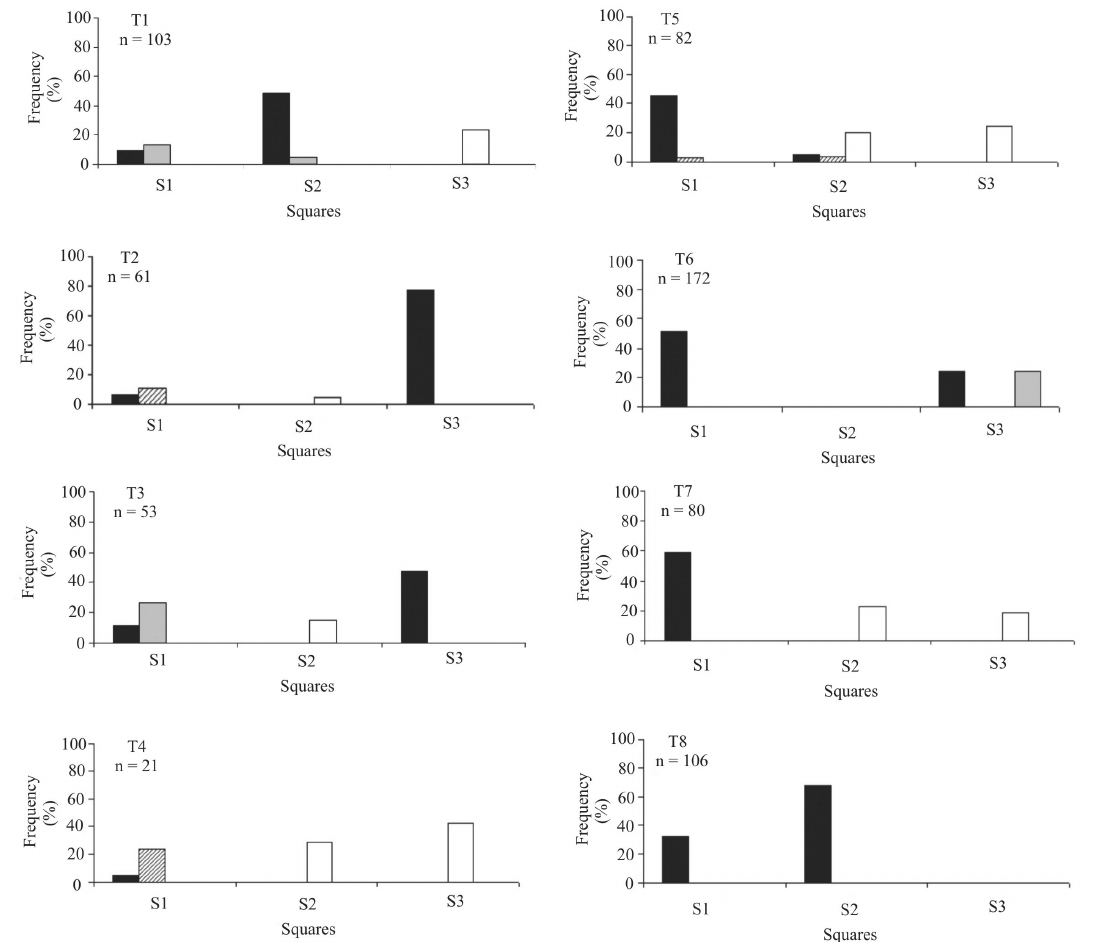
Fig. 3. – Overall frequency distribution of Uca species collected at Pacoti River mangrove, northeast Brazil, in the squares at each transect sam- pled. Black bars: U. leptodactyla , white bars: U. thayeri , hatched bars: U. rapax , grey bar: U. maracoani . Square 1 (S1): Edge of the mangrove vegetation; Square 2 (S2): Middle of the mangrove; Square 3 (S3): Close to the margin/open mud flat. T: Transects; n: Number of individuals.